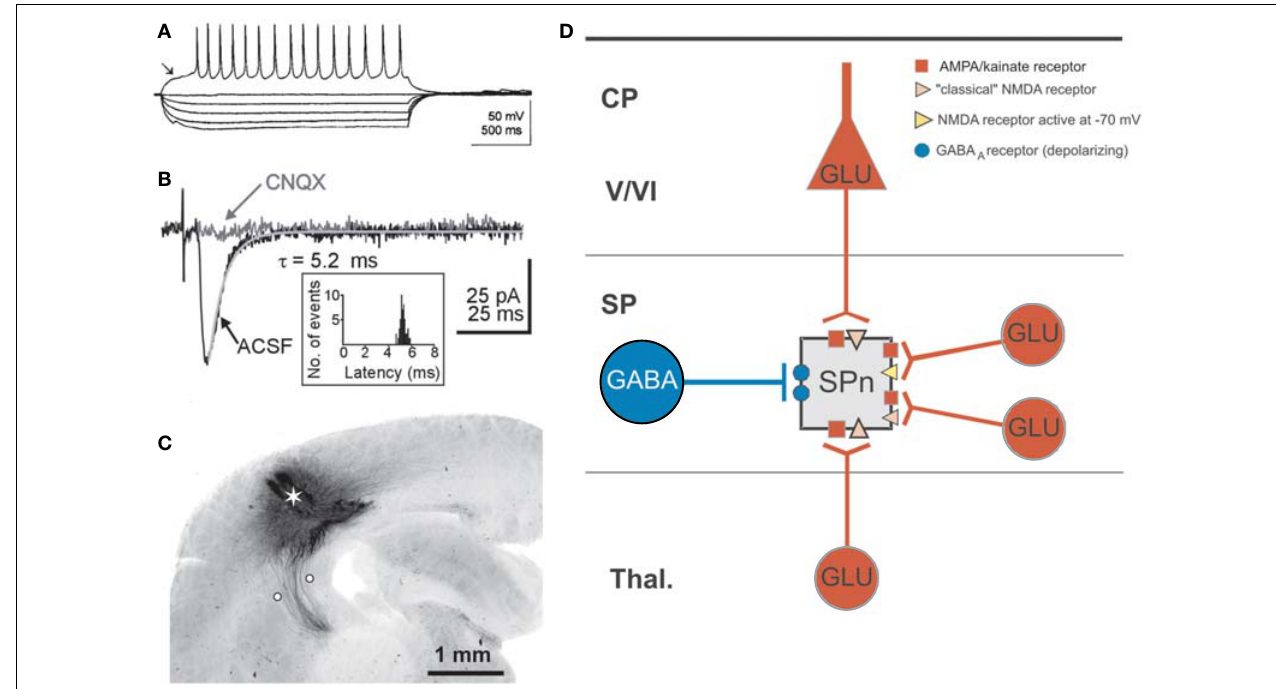
FIGURE 3 | Electrophysiological properties of subplate neurons and their from one SPn. (C) Photomicrograph of biocytin-stained thalamocortical synaptic integration in the developing cerebral cortex. (A) Typical action projections in a 400-µm thick coronal slice from a P1 rat. Asterisk shows potential fi ring pattern of a subplate neuron in the cerebral cortex of a P1 rat. extracellular injection site of biocytin crystal and white circles mark position of Note repetitive discharge pattern and presence of a prominent I current bipolar electrode to selectively activate the thalamocortical input. (D) Schematic A (arrow). (B) Excitatory postsynaptic currents (EPSCs) recorded in a P3 subplate diagram illustrating the distribution of postsynaptic receptors on a subplate cell at a holding potential of − 70 mV and elicited by selective electrical neuron for monosynaptic inputs arising from the thalamus (Thal.), the cortical stimulation of the thalamocortical input (see C). Synaptic responses were plate (CP) including layers V/VI and within the subplate (SP). Note that synaptic obtained under control conditions in normal extracellular bathing solution and inputs from other subplate neurons can lead to activation of depolarizing GABA after application of 10 µM CNQX to block AMPA/kainate receptors. The EPSC receptors and NMDA receptors activated at negative membrane potentials. decay could be fi tted by a monoexponential function (gray line). The inset Reproduced and modifi ed with permission from (Luhmann et al., 2000) shows the unimodal latency distribution of 50 thalamocortical EPSCs recorded (A) (Hanganu et al., 2002) (B–D)